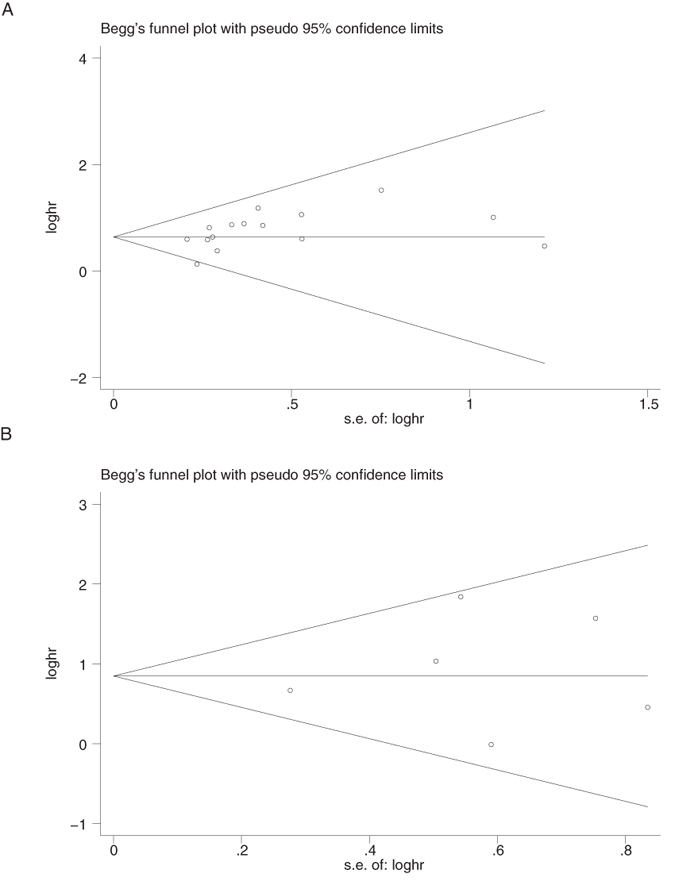
Begg’s funnel plots for the studies involved in the meta-analysis.(A) Overall survival. (B) disease-free survival(DFS). Abbreviations: loghr, logarithm of hazard ratios; s.e., standard error.